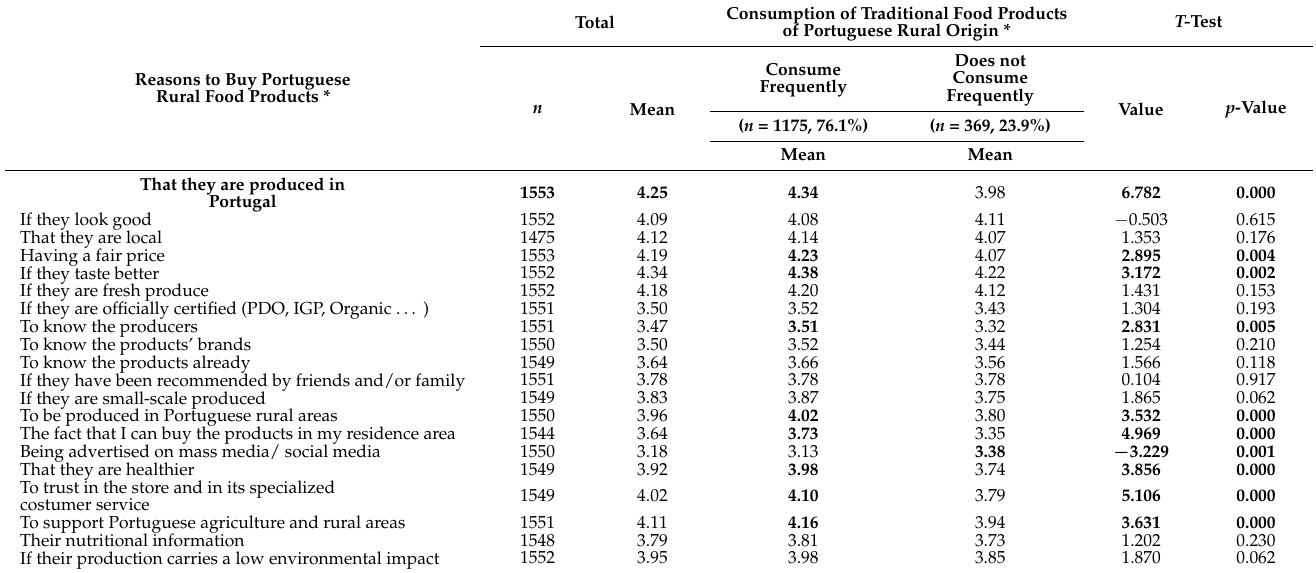
Table 3. Reasons to buy Portuguese rural provenance